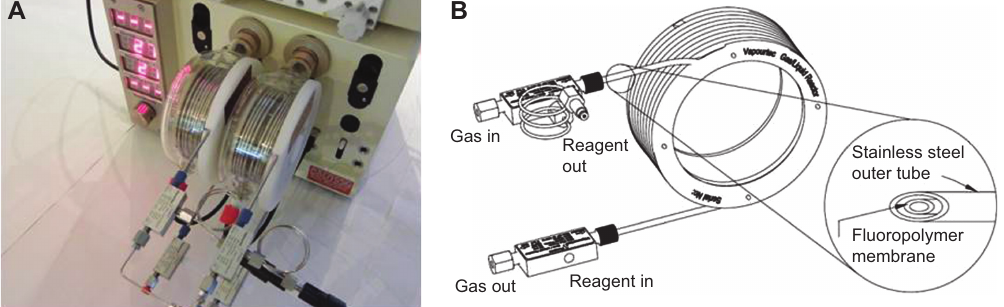
Figure 5 (A) “On-demand” gas reactors interfaced with the flow apparatus and (B) schematic of tube-in-tube gas reactor coil. (Reproduced with kind permission from Vapourtec Ltd, Bury St. Edmunds, Suffolk,